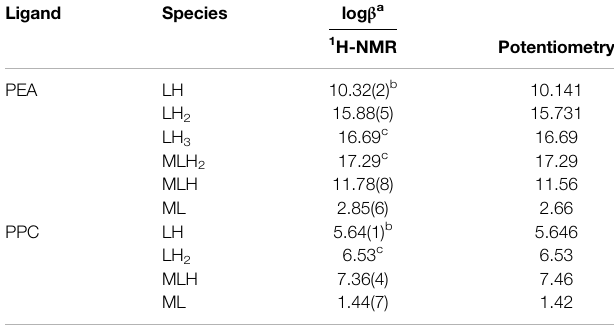
TABLE 2 | Comparison between the experimental protonation constants of PEA and PPC andexperimentalformationconstantsofMg 2+ - PEA andMg 2+ - PPC species obtained via 1 H-NMR and potentiometry at t = 25 ° C and I = 0.15 mol L − 1 .